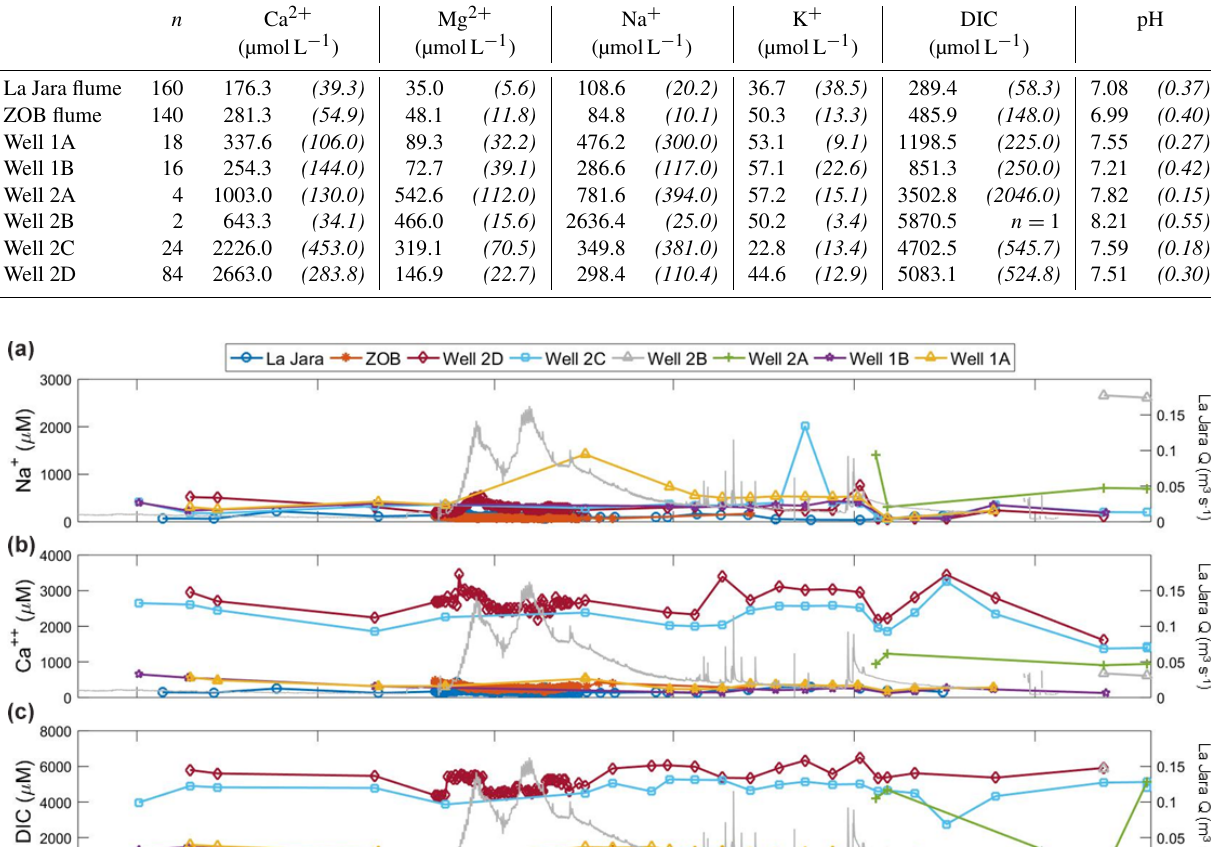
Table 2. Number of samples ( n ) and average concentrations of major ions and pH of surface waters and groundwaters. Standard deviations are shown italicized and in parentheses.